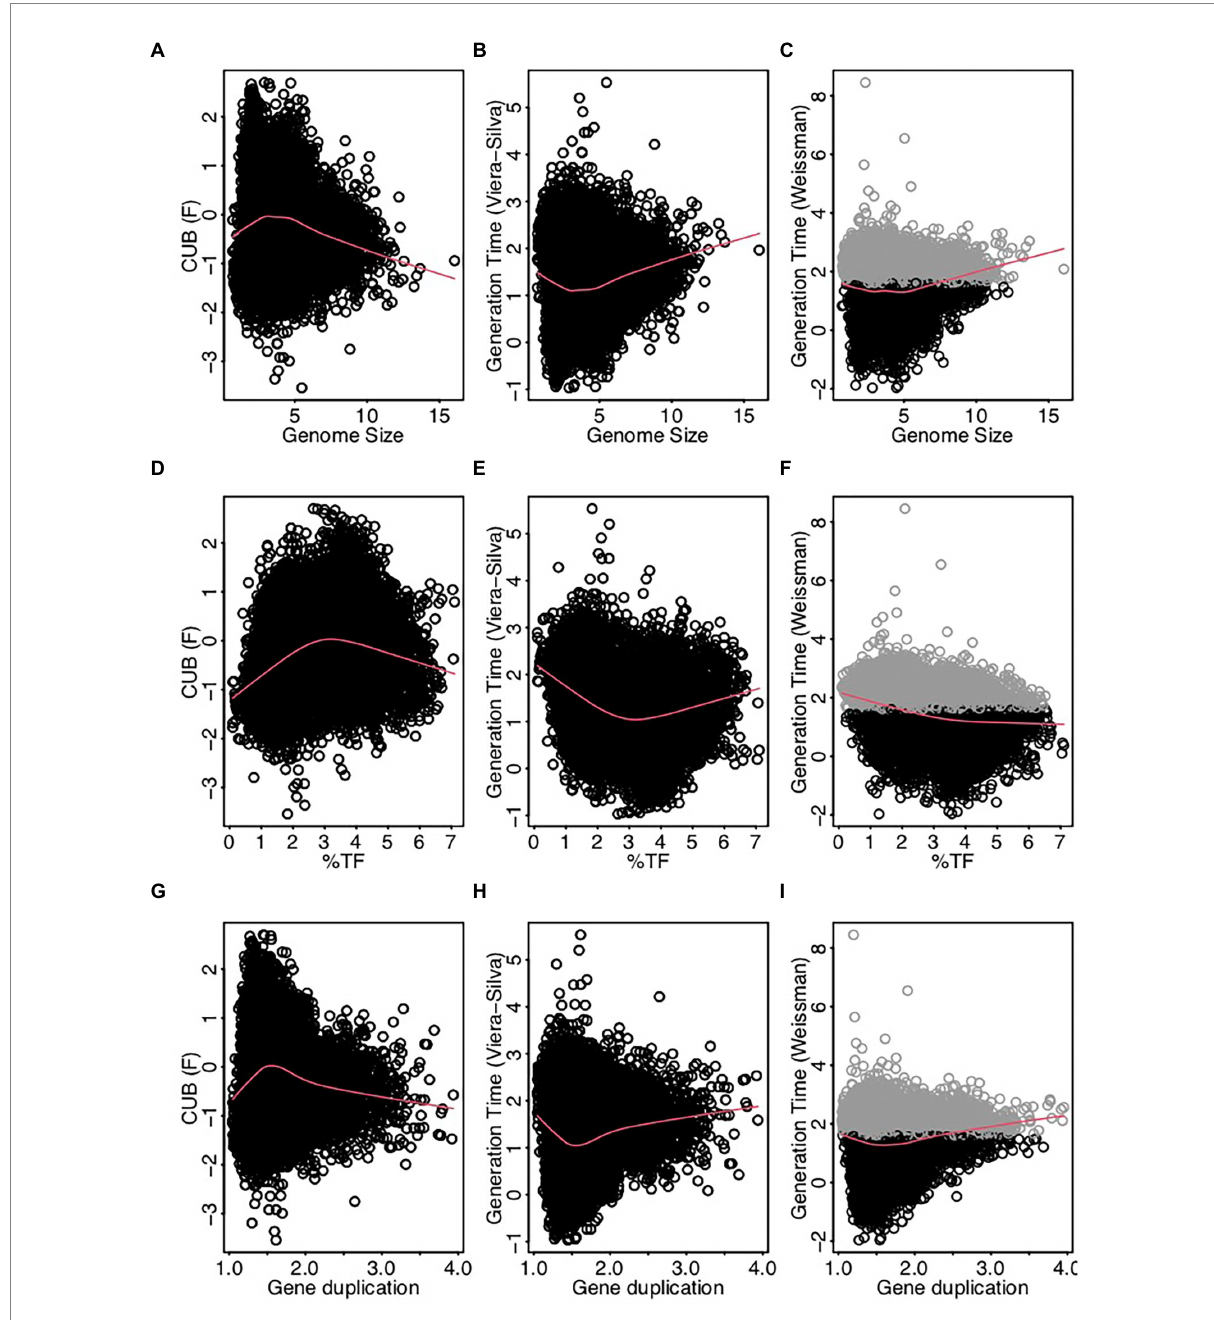
FIGURE 5 Scatterplots displaying pairwise relationships between the codon usage bias (F, Vieira-Silva and Rocha, 2010) the generation time (log- transformed) estimated as detailed in Vieira-Silva and Rocha (2010) and the generation time (log-transformed) estimated using the R package gRodon (v0.0.0.9000, Weissman et al., 2021) against genomes size (A-C) , %TF (D-F) and gene duplication (G-I) . Genomes with low codon usage bias resulting in predicted generations times (gRodon) exceeding 5 h (highlighted in gray) represent species with generations times >5 h, while the exact value is inaccurate. The absence of genomes with elevated generation times at the extremes of the value ranges for the displayed resistance related traits is accordingly independent from these